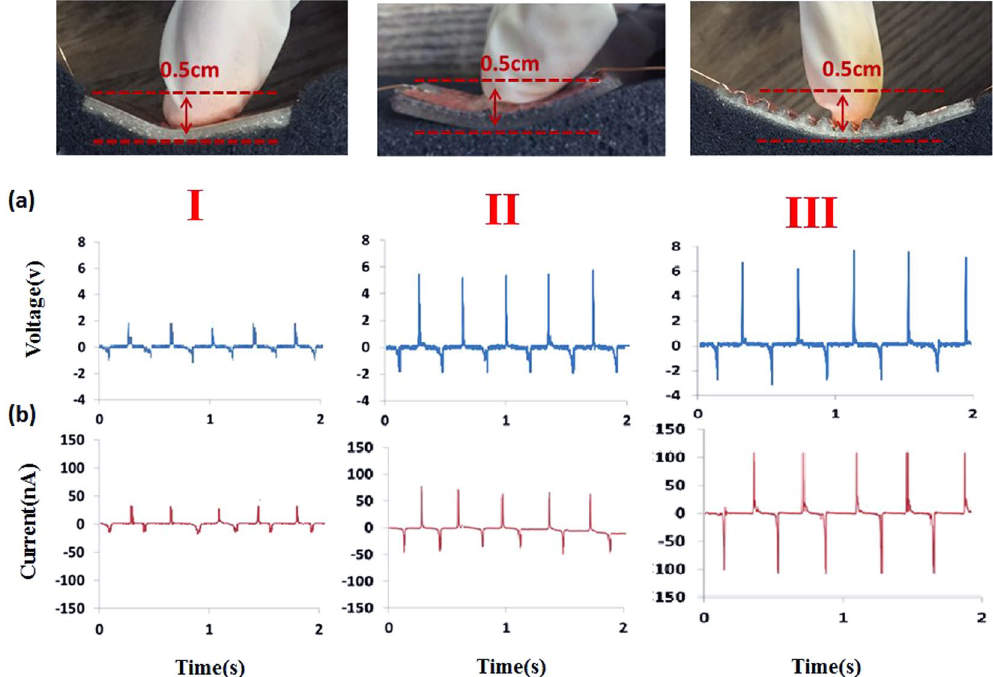
Figure 3. Measured output voltage and current. Placed the device on the cotton fabric and performed the press/ release cycles repeatedly on three different devices to obtain open-circuit ( a ) voltage and ( b ) current. The I/II/III devices produces average output voltage 2 V/5 V/7 V and output current 50 nA/80 nA/110 nA, respectively.